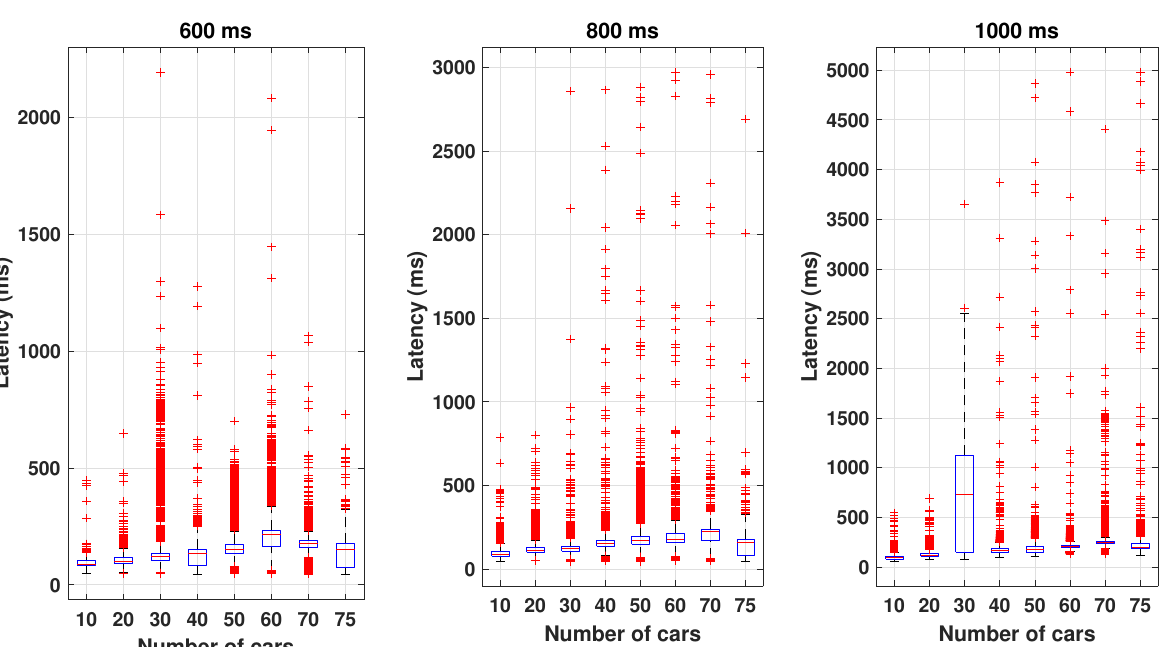
Figure 22. Latency values for 600 ms, 800 ms, and 1000 ms dissemination interval when both ITS-Ss use LTE